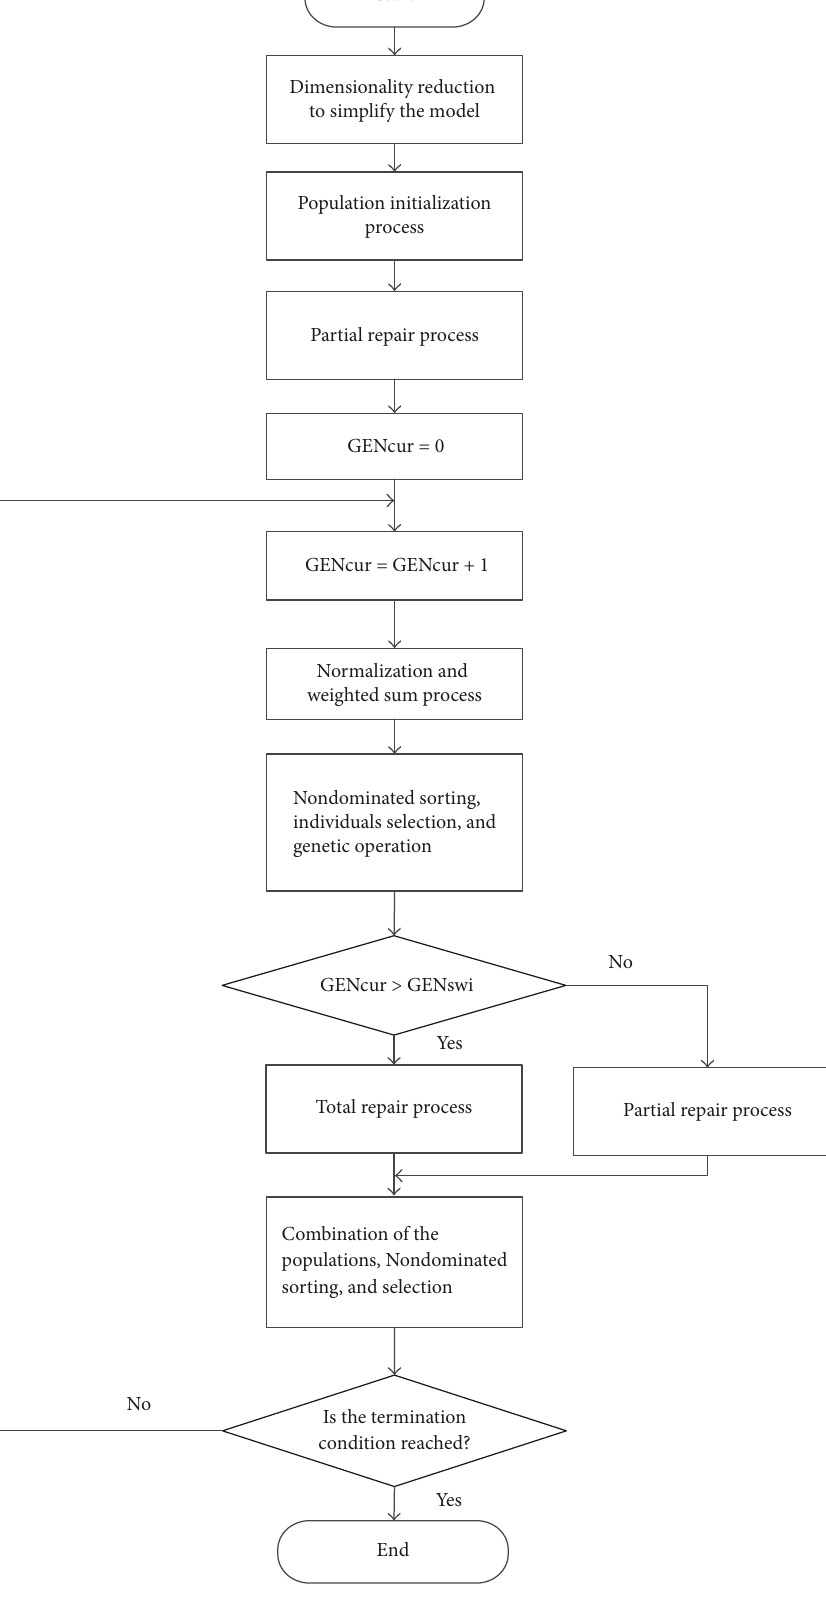
Figure 2: Flowchart of